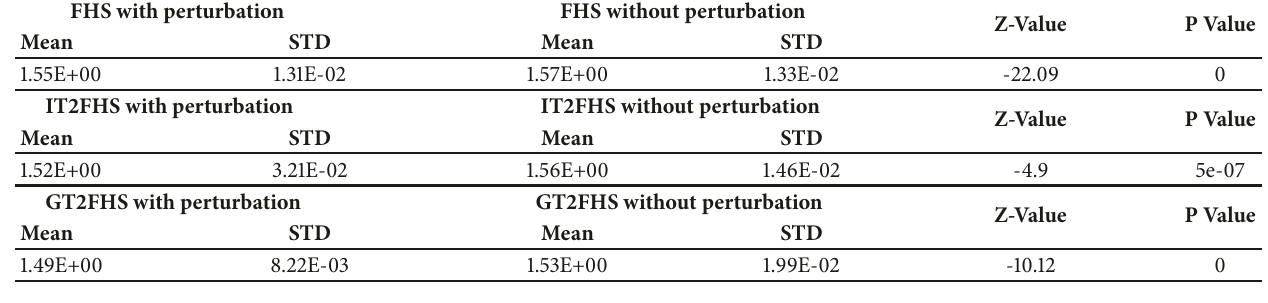
Table 8: Results for the statistical test .